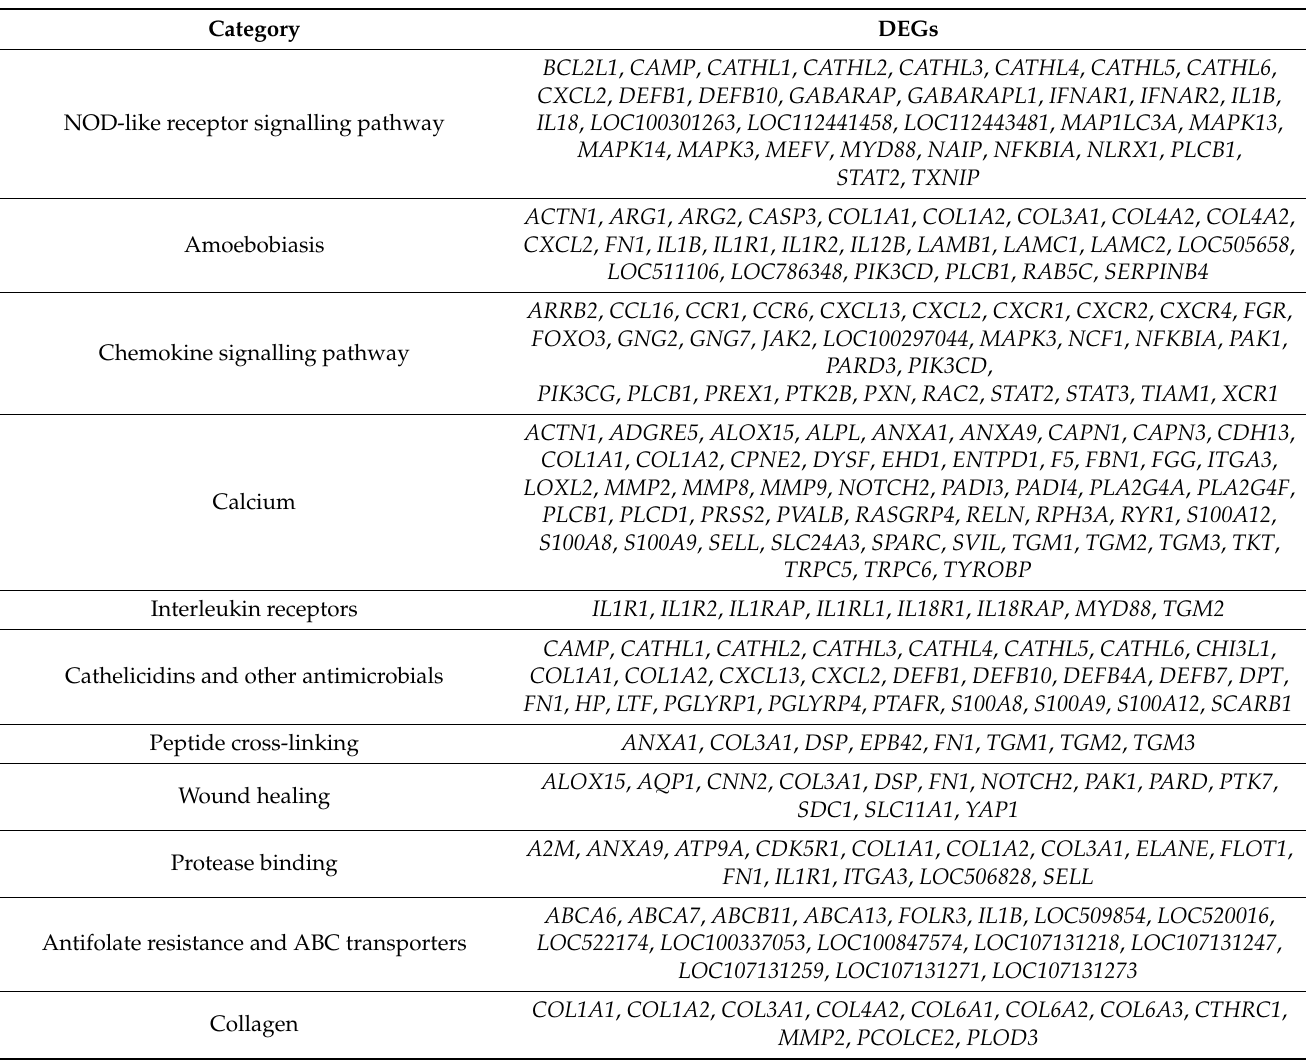
Table 2. Gene lists from the main terms identified by DAVID chart analysis associated with differen- tially up-regulated genes in leukocytes collected from cows with E. coli (+) (EARLY) compared with healthy CONT cows ( n = 6 cows/group) #